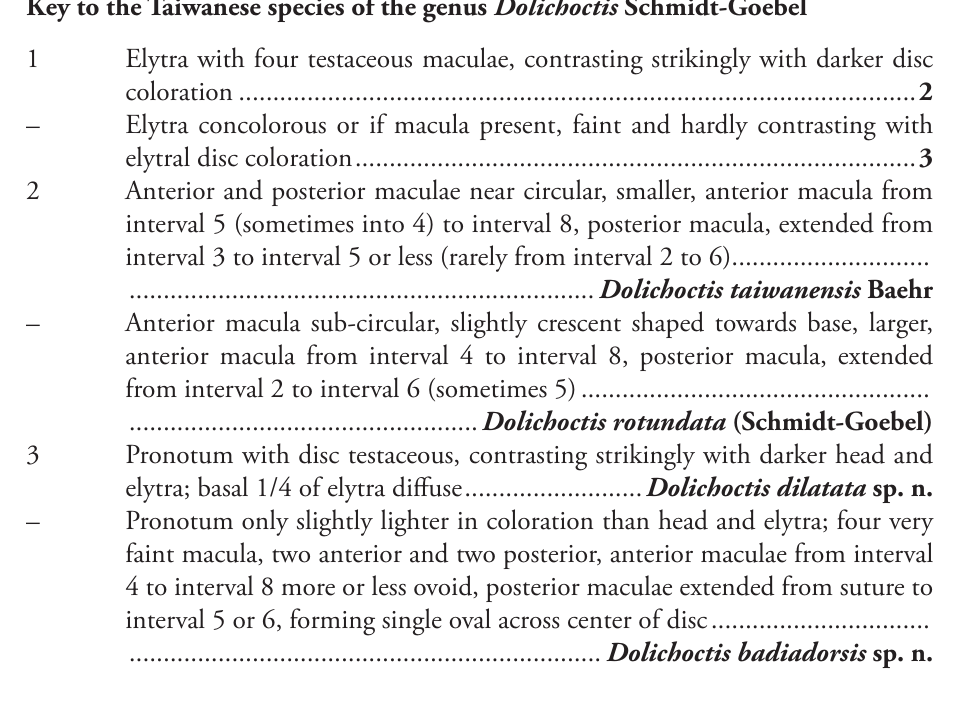
Pronotum with disc testaceous, contrasting strikingly with darker head and Pronotum only slightly lighter in coloration than head and elytra; four very faint macula, two anterior and two posterior, anterior maculae from interval 4 to interval 8 more or less ovoid, posterior maculae extended from suture to